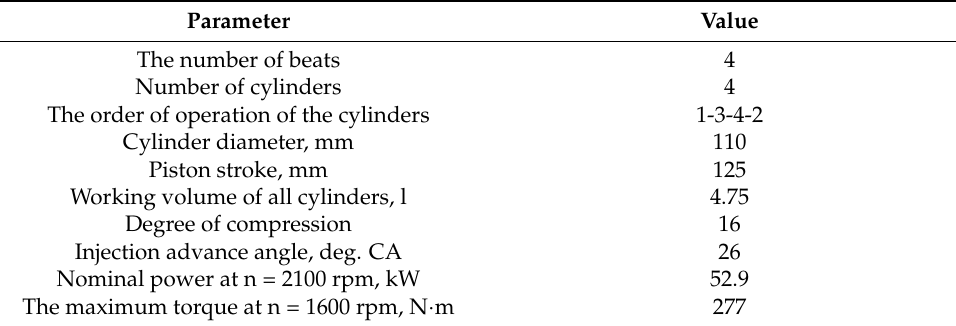
Table 1. Main characteristics of the diesel engine D-241. Parameter Value The number of beats The order of operation of the